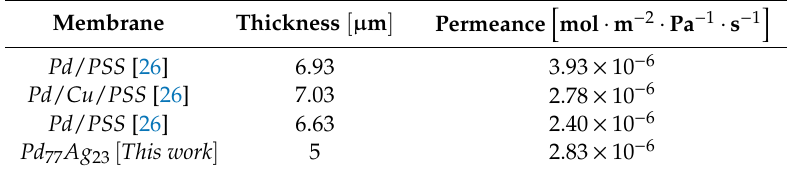
Table 2. Comparison of the determined permeances with a fit at n = 1 with the data provided in the work of Chen et al. [26]. Only membranes with high permeance are